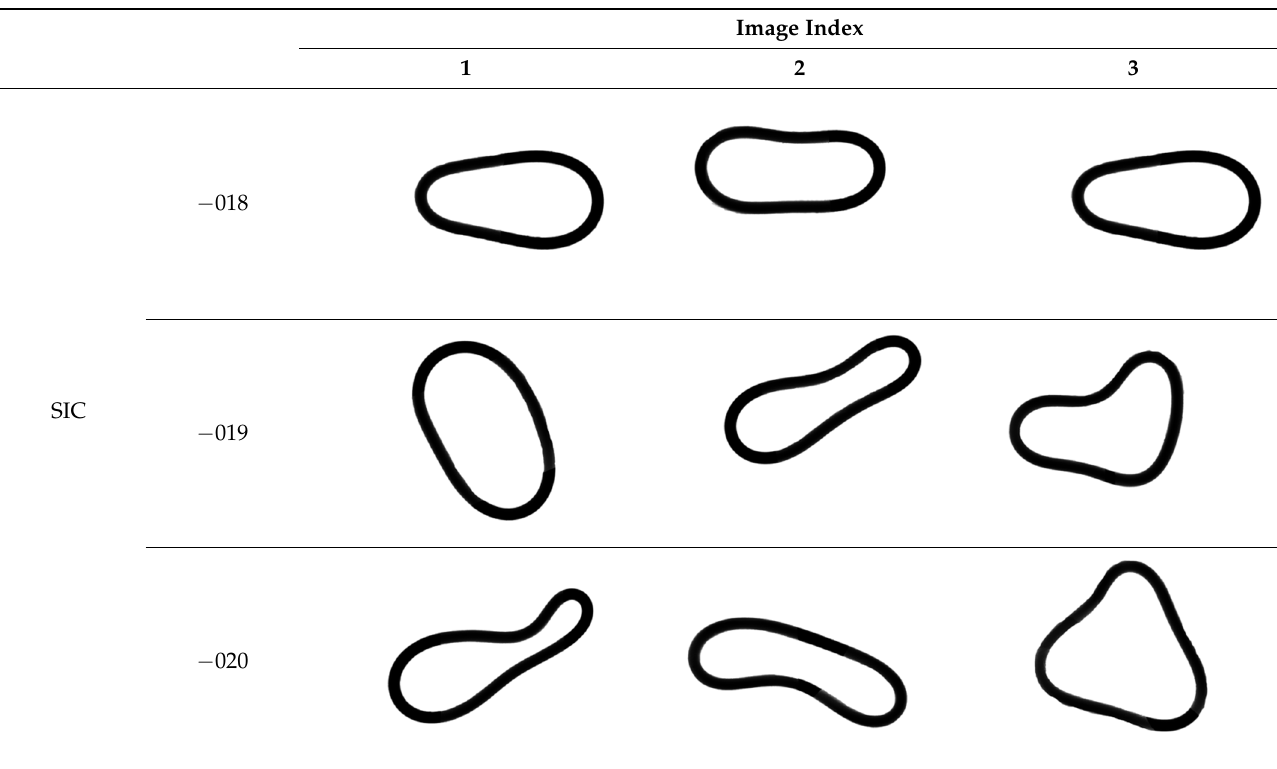
Table 4. Table of DPS (database of photometric stereo model) with SIC (size identification code) and image index. Image Index